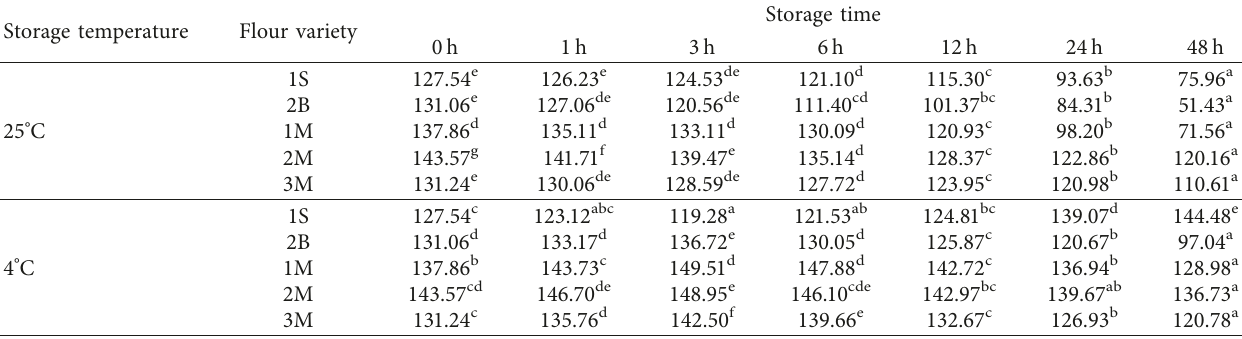
Table 5: Water absorption rate of fresh wet noodles made from different flours during storage. Storage